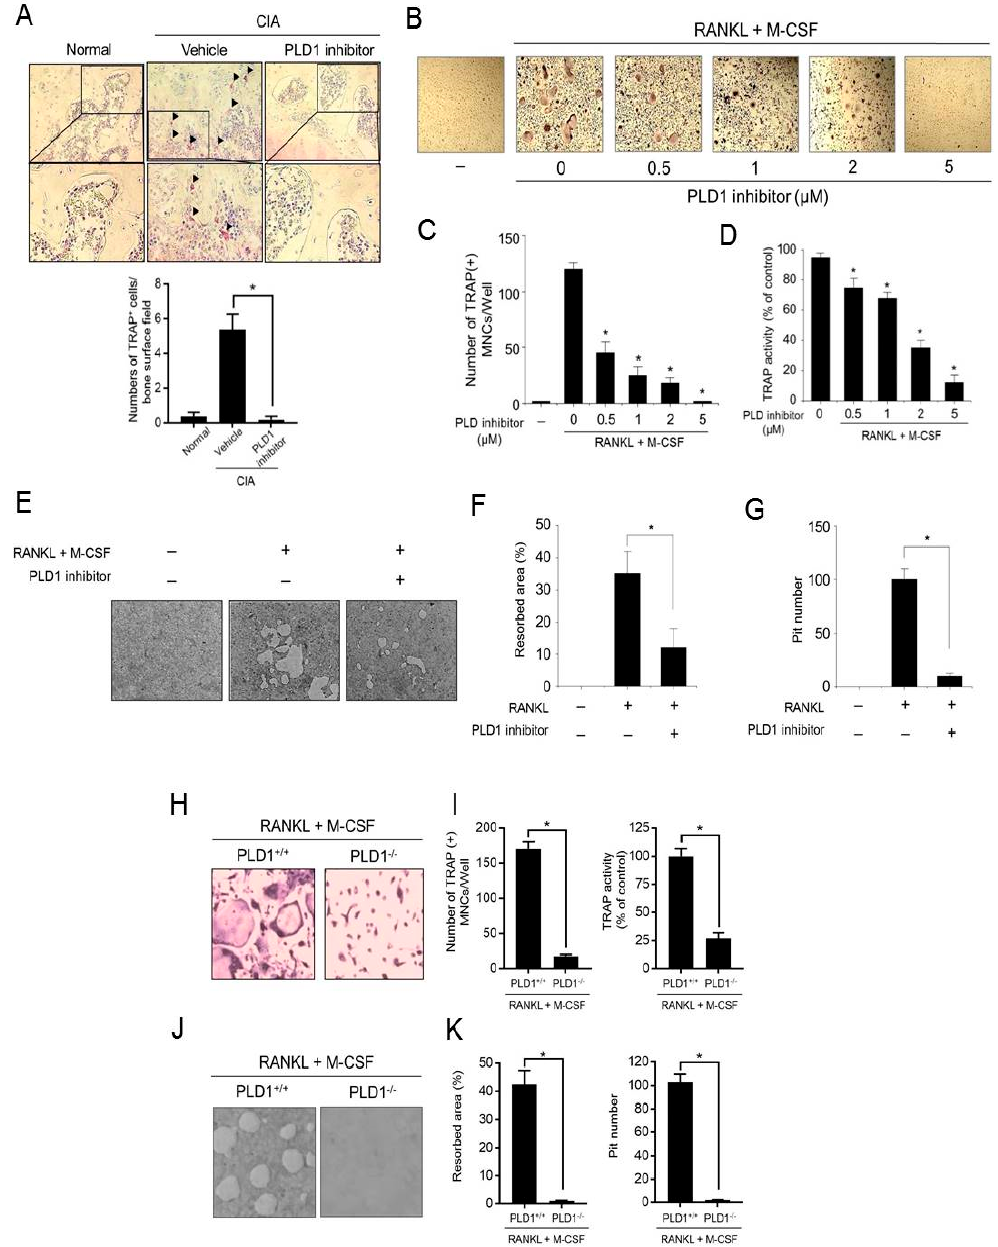
Figure 7. Targeting of PLD1 reduces osteoclastogenesis and bone resorption. ( A ) Representative histological images of tartrate-resistant acid phosphatase (TRAP) staining for osteoclasts (red) at a region distant to the site of inflammation in the proximal tibia of mice from different groups at day 45. ( B ) Representative TRAP staining images of osteoclasts differentiated by RANKL and M-CSF induction in the presence of the indicated concentration of the PLD1 inhibitor in murine bone marrow cells (BMMs). ( C , D ) The cells were stained with TRAP and the number of multinucleated (nuclei ≥ 3) TRAP + cells ( C ) and TRAP activity ( D ) were counted. ( E ) Representative images of bone resorption assay in differentiated osteoclasts. ( F , G ) Effect of the PLD1 inhibitor on the relative bone resorption area ( F ) and pit number ( G ). Representative TRAP staining images ( H ) and TRAP-positive cell numbers and TRAP activity ( I ) of the osteoclasts differentiated from BMMs from PLD1 +/+ and PLD1 − / − mice. Representative bone resorption images ( J ) and resorbed area and pit number ( K ) of the osteoclasts differentiated from BMMs from PLD1 +/+ and PLD1 − / − mice. n = 6 per group. * p < 0.05. Results are representative of at least six independent experiments and are shown as mean ± standard error of the mean (SEM).